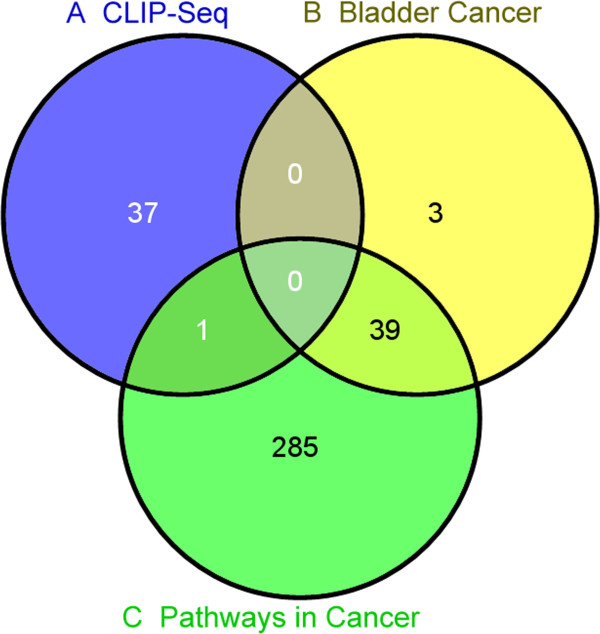
Venn diagram of 38 target genes of miR-127. There are 42 genes in the bladder cancer pathway and 325 genes in the cancer pathway.